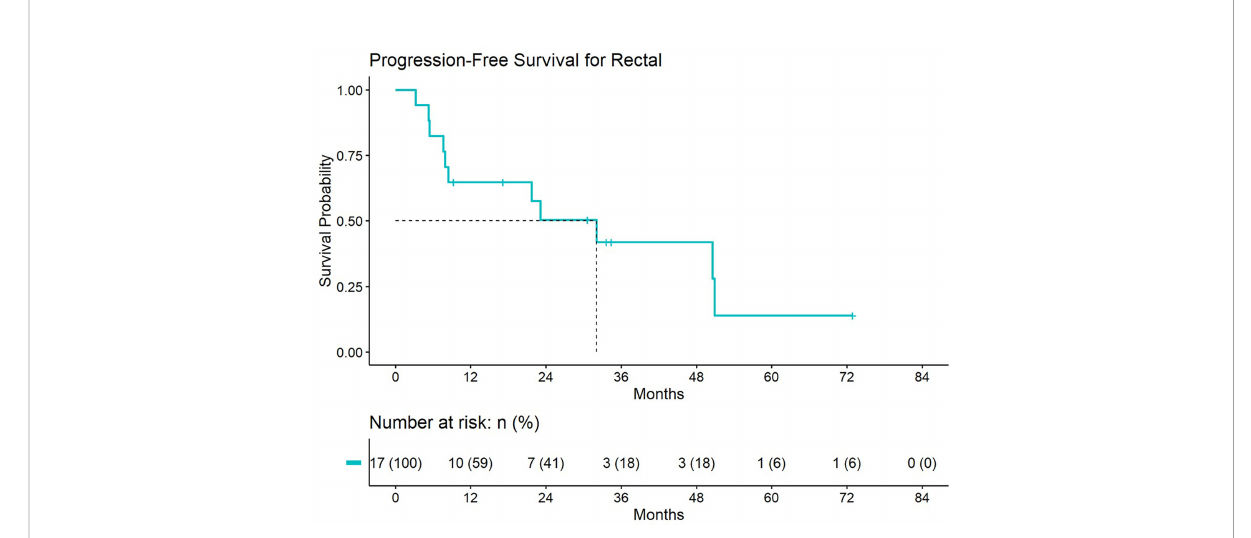
FIGURE 4 Progression free survival for patients treated with a second course of pelvic radiation for de novo rectal cancers after prior prostate